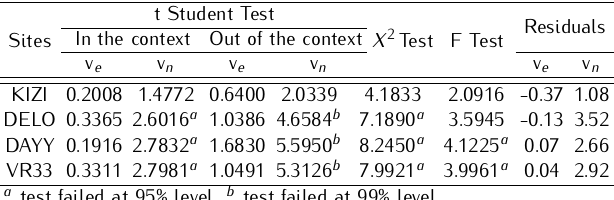
Table 3. Tests results (block B2). The results of the statistical tests for the GPS site data components. The sites passed from all the tests are the accepted data. The tests have been performed in two confidence levels (95% and 99%). Sites